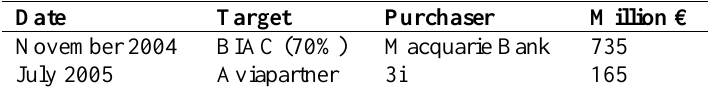
Table 9. Private equity in the Belgian airline